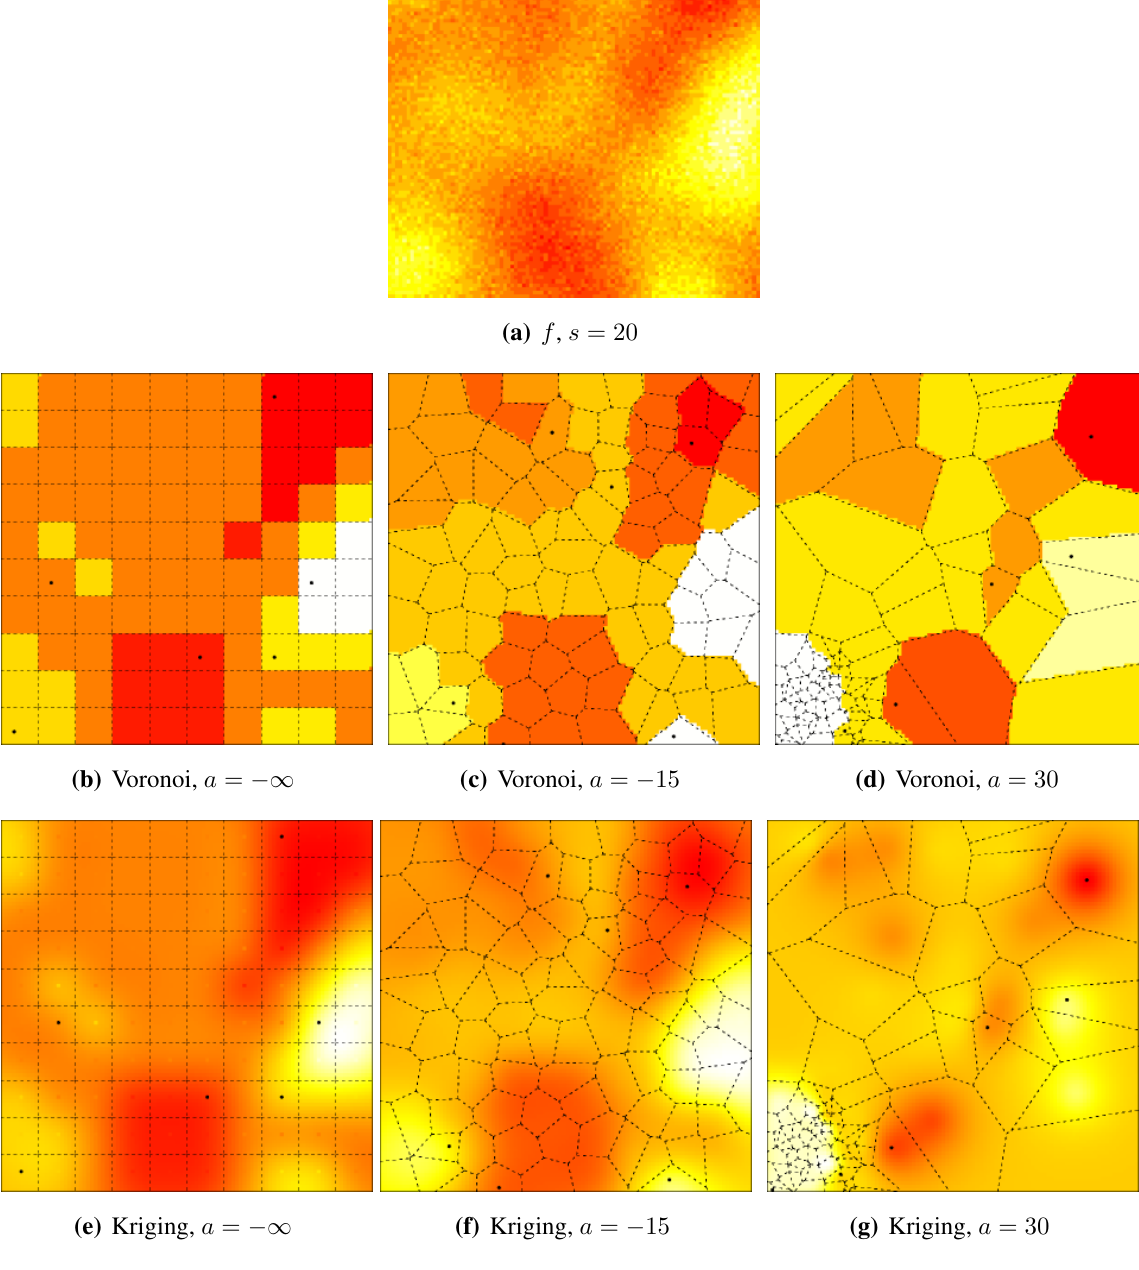
Figure 5. The influence of sensor deployment using SKATER, coarse data